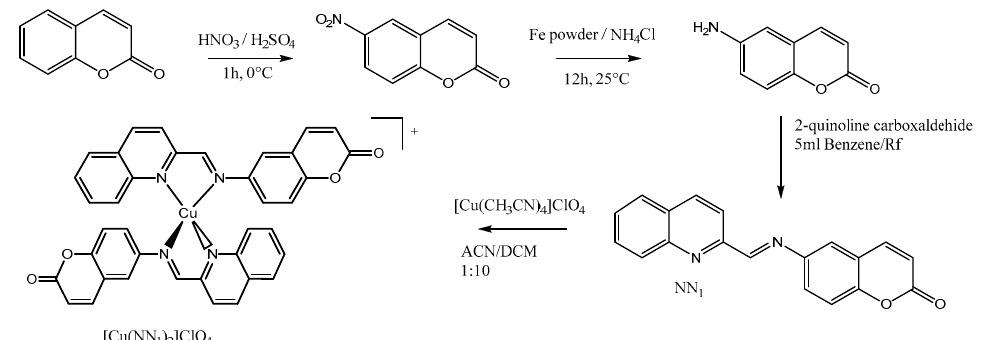
Figure 1. Synthesis scheme [Cu(NN 1 ) 2 ]ClO 4 .